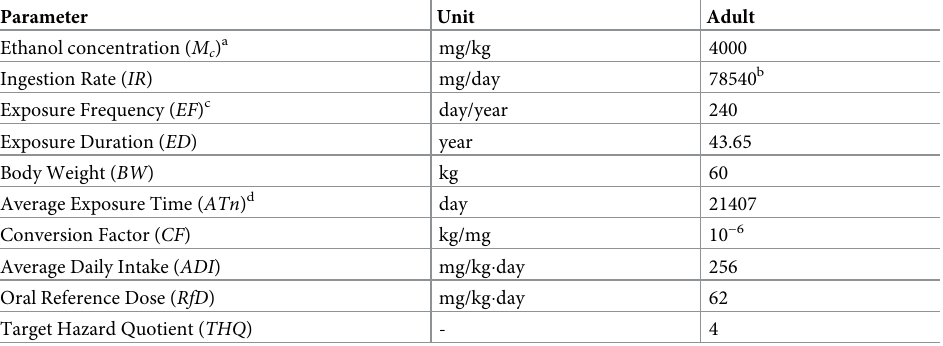
Table 2. Exposure parameters used for assessing the health risk of consuming 40% (v/v) sachet ethanol in Acoli, Uganda. Parameter Unit Adult Ethanol concentration ( M c ) a mg/kg 4000 Ingestion Rate ( IR ) Exposure Duration ( ED ) year 43.65 Body Weight ( BW